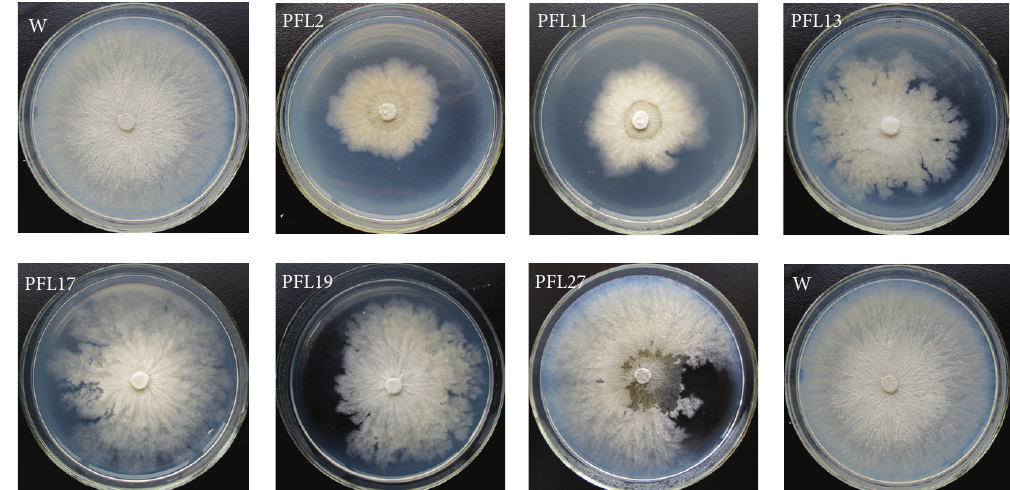
Figure 5: Colony morphology of six transformants and wild-type strain LXS240101 (W) on PDA medium. Wild-type LXS240101 (W) shows normal growth on PDA plates and 6 independent transformants (PFL2, PFL11, PFL13, PFL17, PFL19, and PFL27) exhibit different colonial morphologies and radial growth rates. The plates were incubated at 25 ∘ C for 72